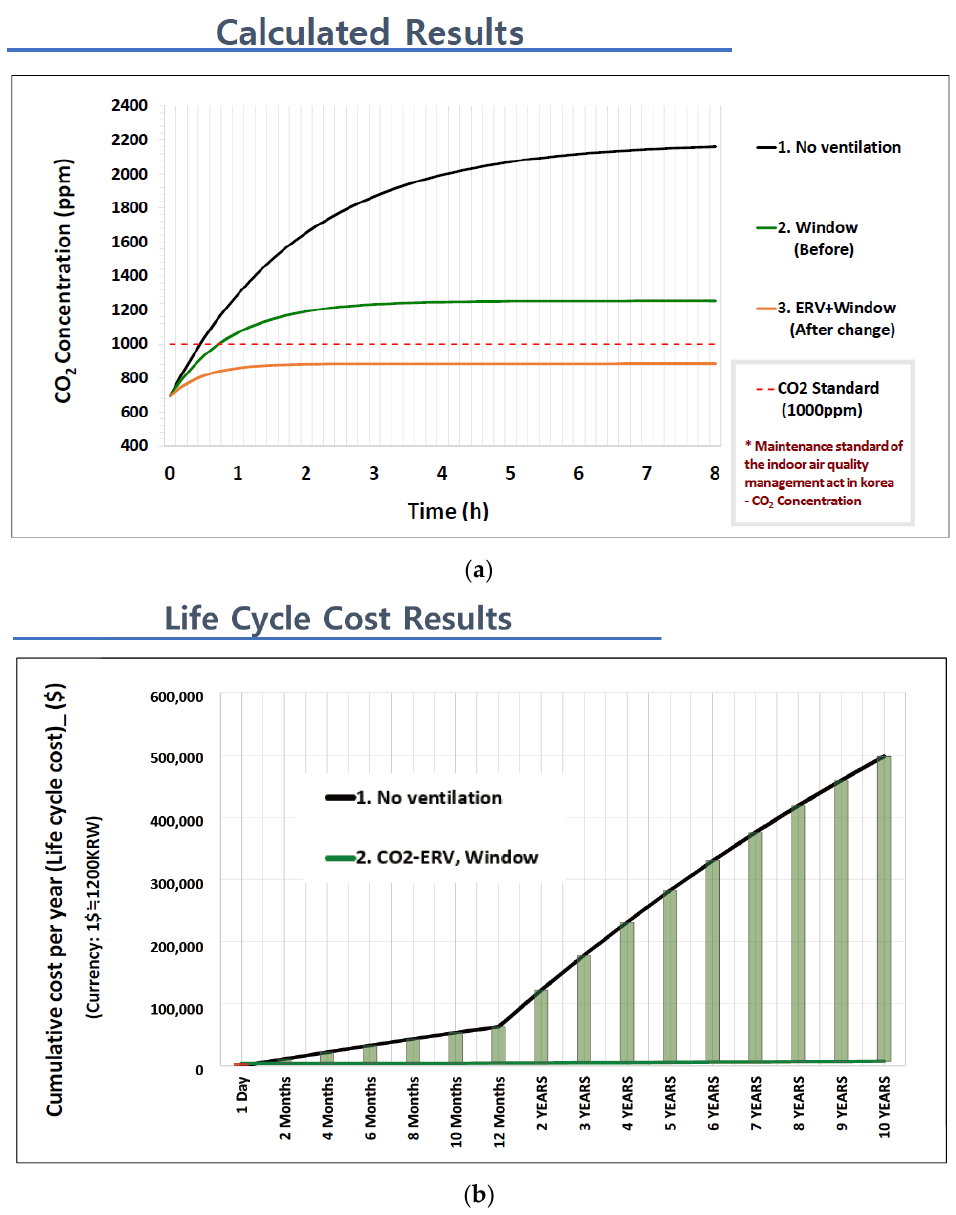
Figure 19. ( a ) Indoor CO 2 concentration results of Office Space B; * CO 2 standard-maintenance stand- ard of the indoor air quality management act in Korea, and ( b ) results of economic analysis for 150 cmh ERV application of Office Space